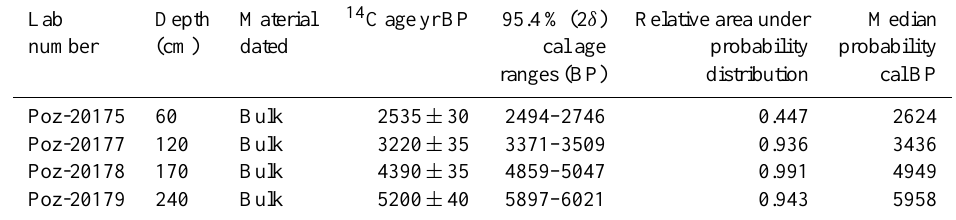
Table 1. Radiocarbon ages for the Hach-I core. Calibrations were performed using Calib 7.1 (Stuiver and Reimer, 1986).